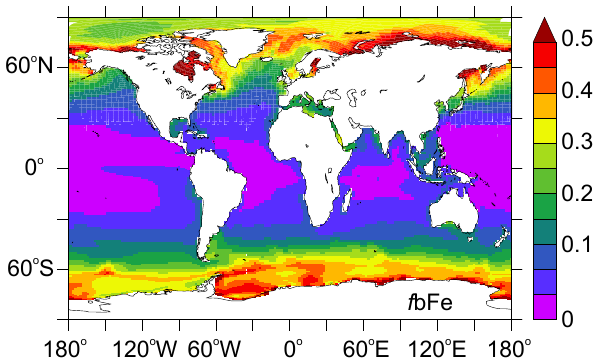
Fig. 5. The annually averaged proportion of the dFe pool present as bFe pool when bFe is assumed to only equal Fe(II) + Fe(III) (compare to Fig. 4a).